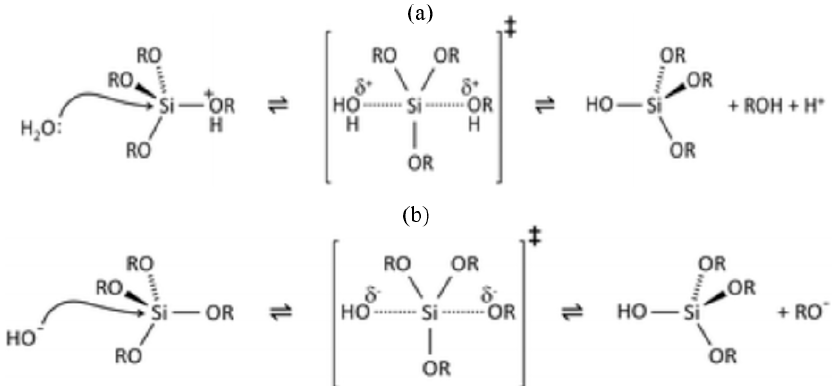
Figure 2. ( a ) Acid- and ( b ) base-catalyzed hydrolysis of silicon alkoxides. The alkoxy group (OR) (such as methoxy (OCH 3 ), ethoxy (OC 2 H 5 ) or acetoxy (OCOCH 3 )) is replaced with the hydroxyl with a pentacoordinate transition state [26].